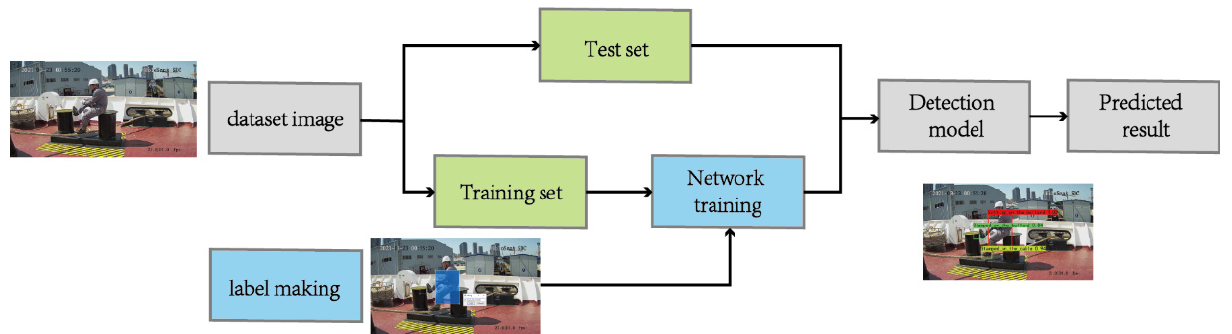
Figure 9. Object detection flowchart using YOLO-v4.